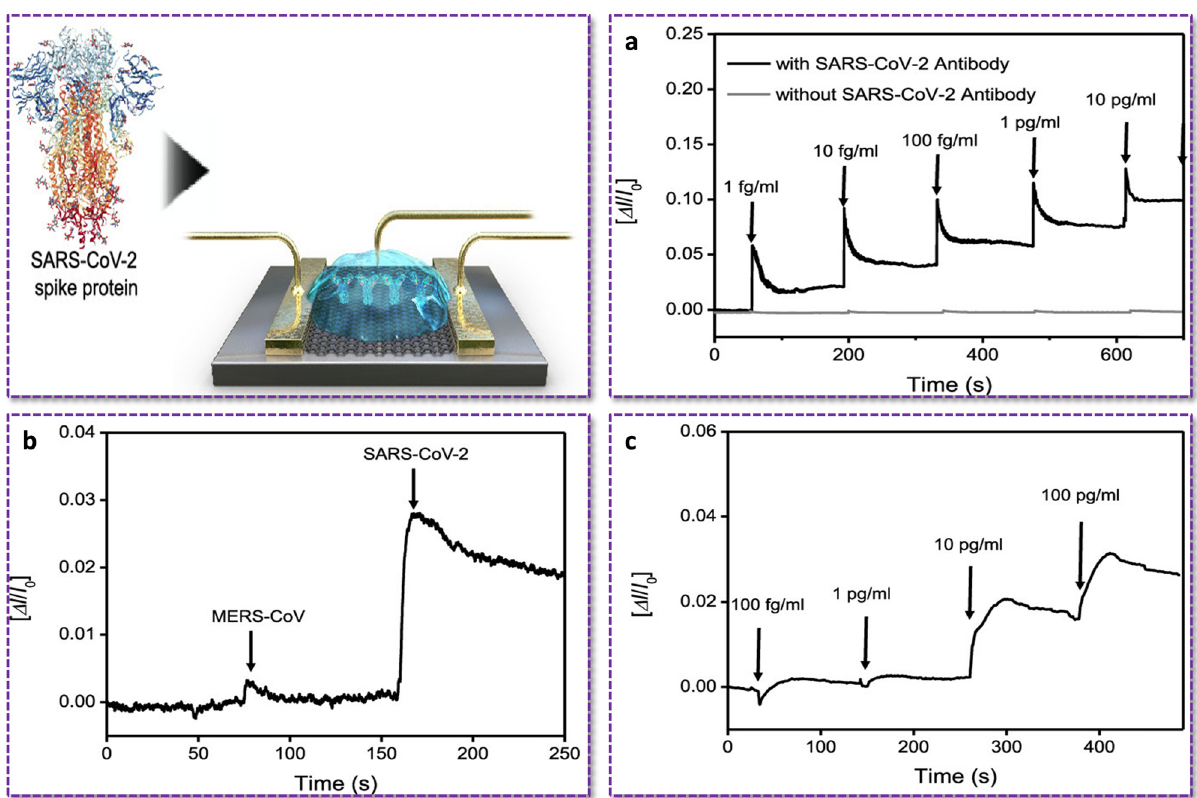
Figure 6: Schematic diagram for detection of SARS - CoV - 2 cultured virus. ( a ) Real - time response of COVID - 19 FET toward SARS - CoV - 2 antigen protein in PBS; ( b ) Selective response of COVID - 19 FET sensor toward target SARS - CoV - 2 antigen protein and MERS - CoV protein; and ( c ) Real - time response of COVID - 19 FET toward SARS - CoV - 2 antigen protein in UTM [ 75 ]